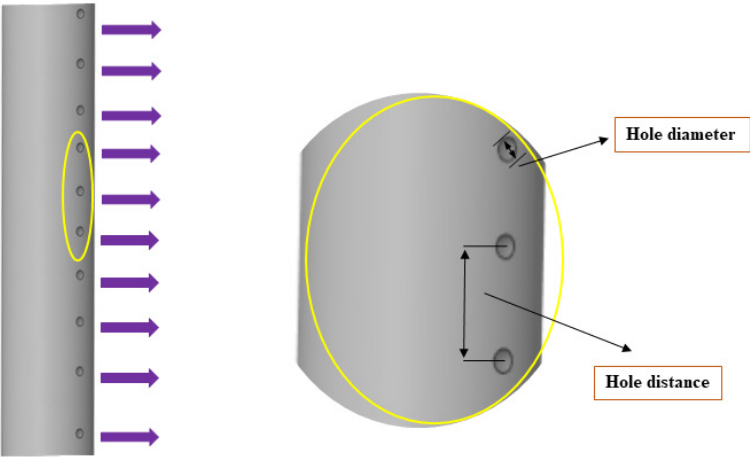
Figure 4. Model of air curtain.